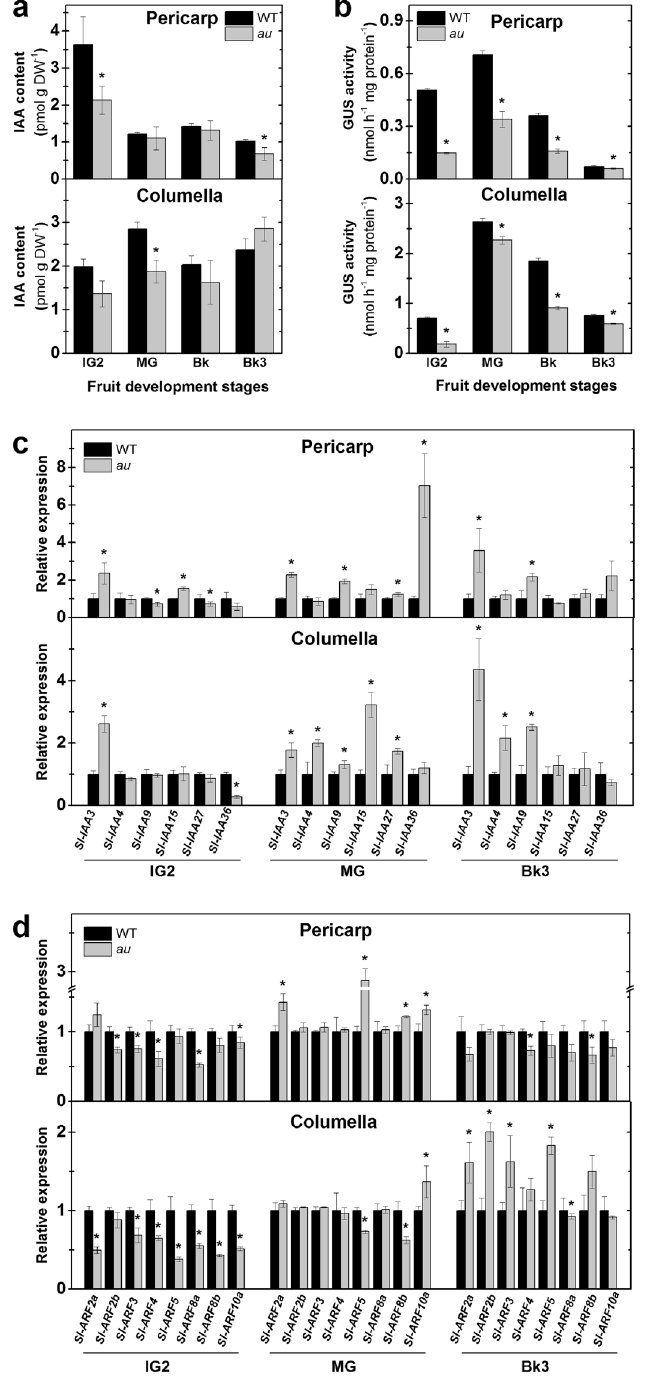
Figure 5. Phytochromobilin deficiency negatively impacts auxin levels and signaling during early tomato fruit development. Auxin content, signaling output and transcript abundance of genes associated with auxin signal transduction were monitored in pericarp and columella tissues of immature (IG), mature green (MG), breaker (Bk) and ripening (Bk3, 3 days after breaker) fruits of wild-type (WT) and aurea ( au ) mutant plants. (a) Indole- 3-acetic acid (IAA) content. (b) In vitro GUS activity assayed in fruits carrying the synthetic auxin-responsive promoter DR5 fused to the GUS reporter protein ( DR5::GUS and au-DR5::GUS ). (c) Relative transcript abundance of AUXIN/INDOLE-3-ACETIC ACID ( Aux/IAA ) genes. (d) Relative transcript abundance of AUXIN RESPONSE FACTOR ( ARF ) genes. The mean relative expression was calculated from means of two technical replicates of at least three biological replicates and normalized against WT at each fruit developmental stage. Values shown are mean ± SE. Asterisks indicate statistically significant differences (Student’s t-test, P < 0.05) compared with the WT at each fruit development